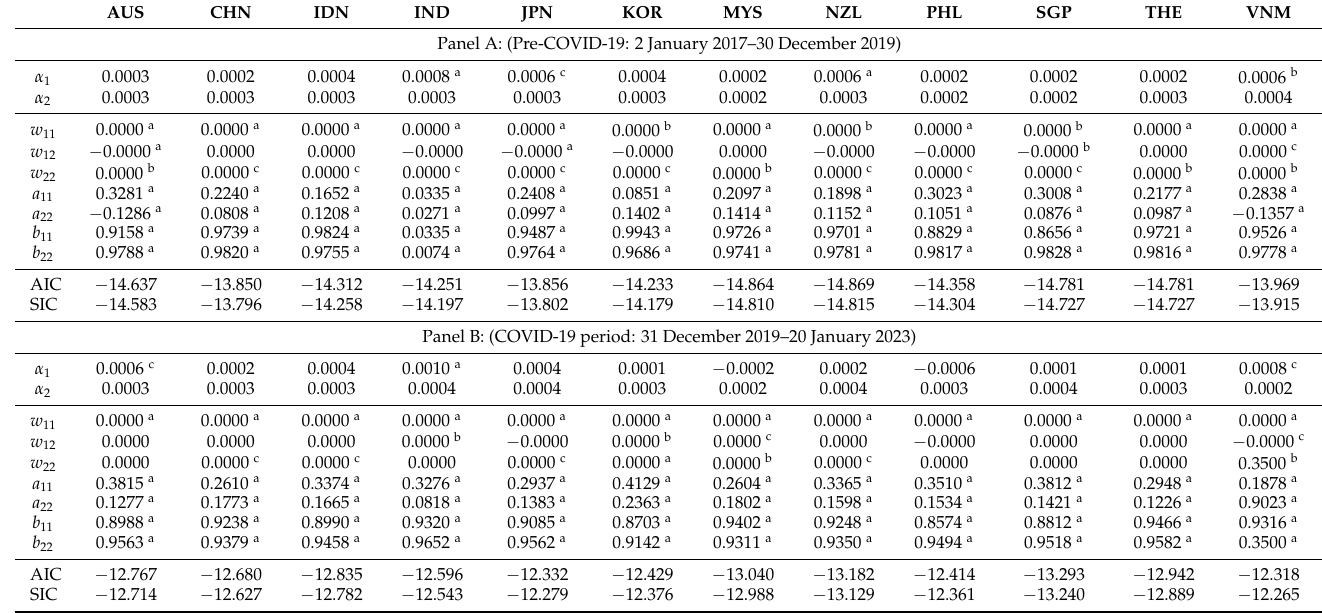
Table 5. BEKK–GARCH estimated results between gold and ASEAN+6 stock